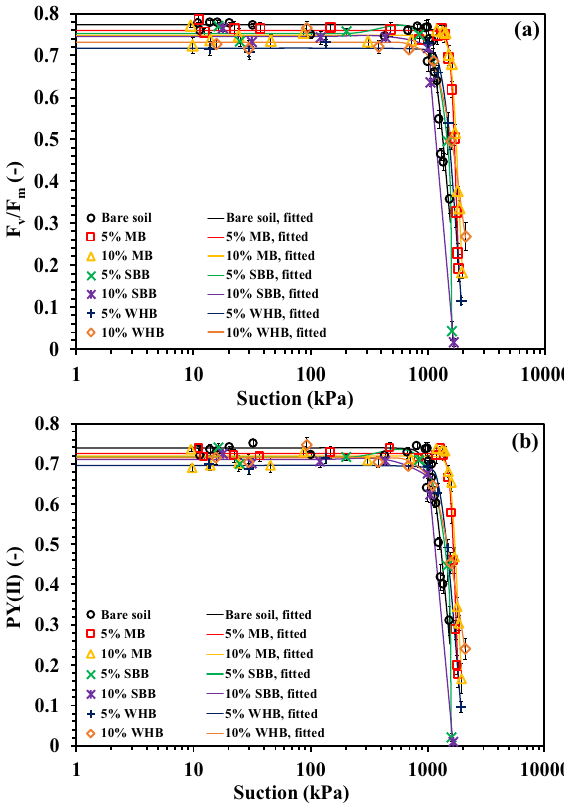
Figure 10. Variation of ( a ) F v /F m and ( b ) PY (II) with suction in different